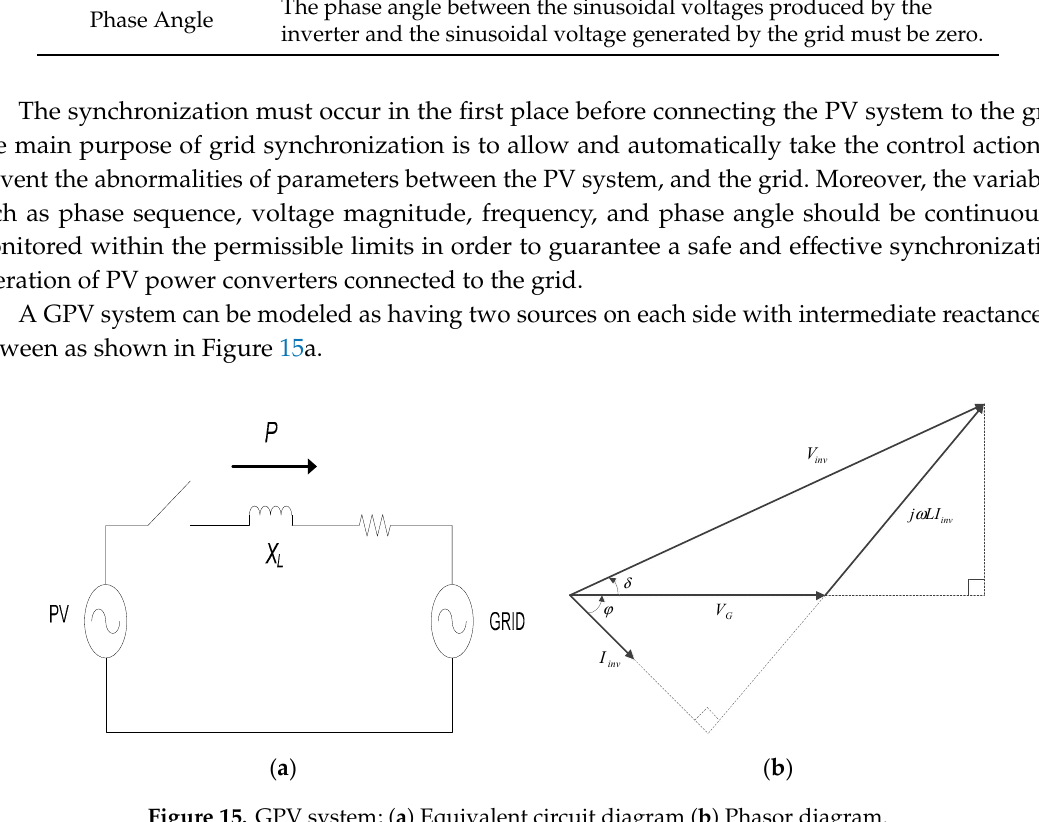
Figure 15. GPV system; ( a ) Equivalent circuit diagram ( b ) Phasor diagram.